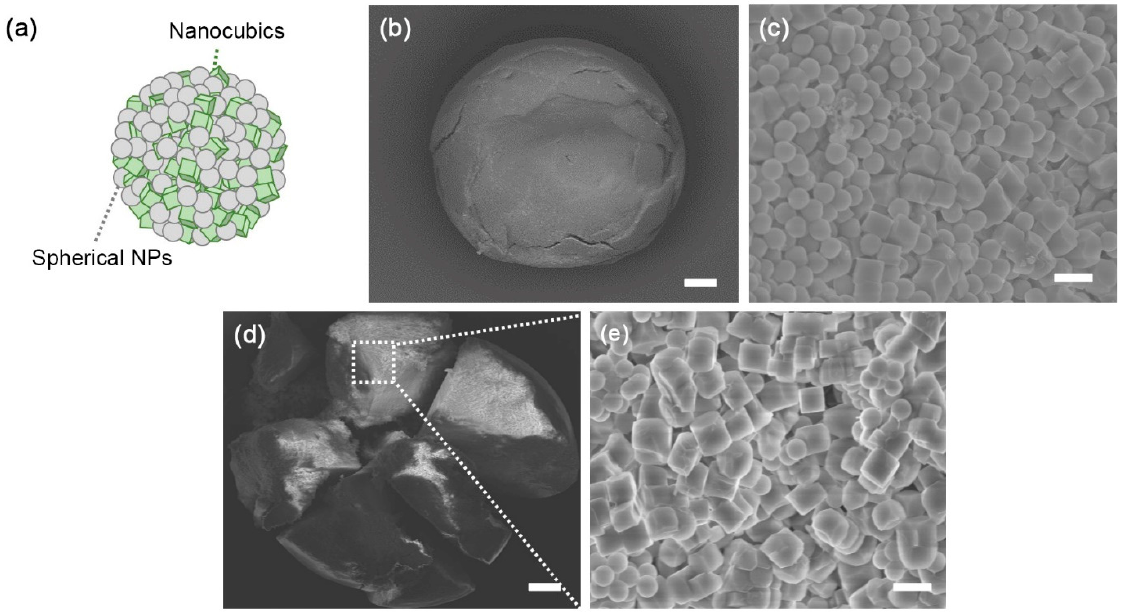
Figure 6. Well-mixed assembly of the supraparticle. ( a ) A schematic of the well-mixed supraparticle with nanocu- bics/spherical NPs. ( b , c ) SEM images of surface of the well-mixed supraparticle. ( d ) Cross-sectional SEM image of the well-mixed supraparticle, characterized after breaking the supraparticle. ( e ) High magnification SEM image of the inner-structure of the well-mixed supraparticle. The scales are 100 µ m for ( b , d ) and 1 µ m for ( c , e ).